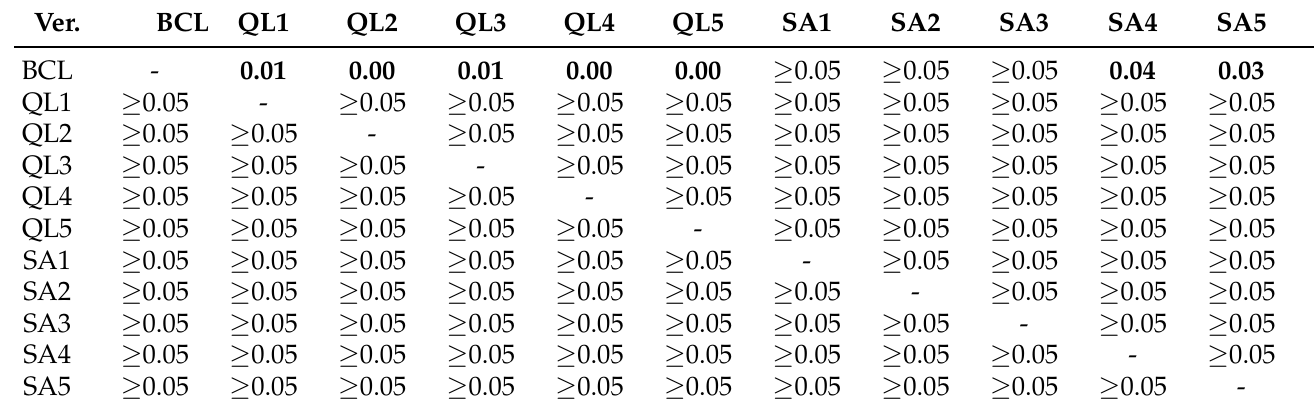
Table 17. The average Wilcoxon–Mann–Whitney test of GWO.